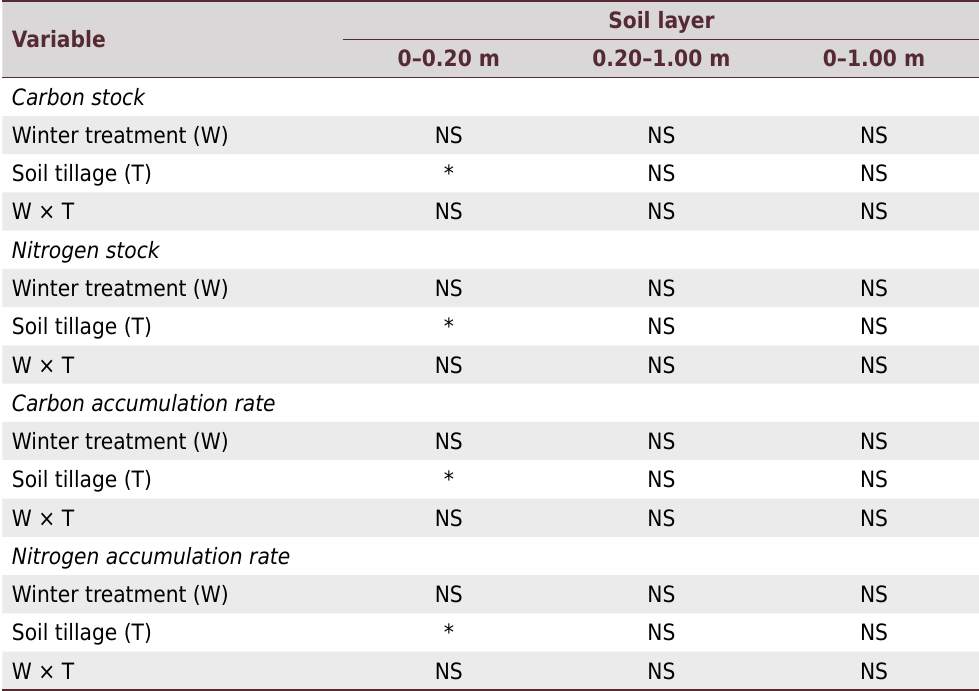
Table 3. Significance of the effects of experimental factors and their interactions as resulting from analysis of variance (ANOVA) for C and N stock and accumulation rates